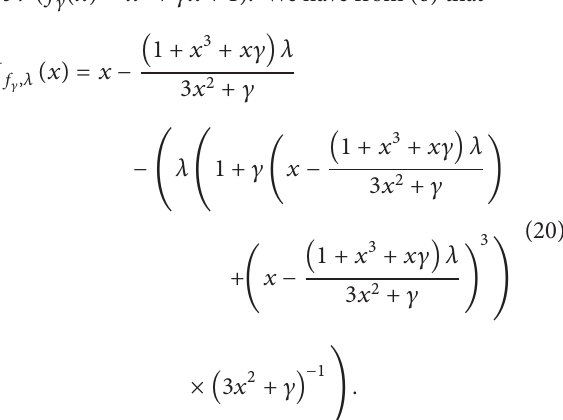
which is a linear contraction for every value of 𝜆 ∈ (0, 1] . The only fixed point is attracting, but not superattracting and the is dynamics of 𝑀 𝑓 0 ,𝜆